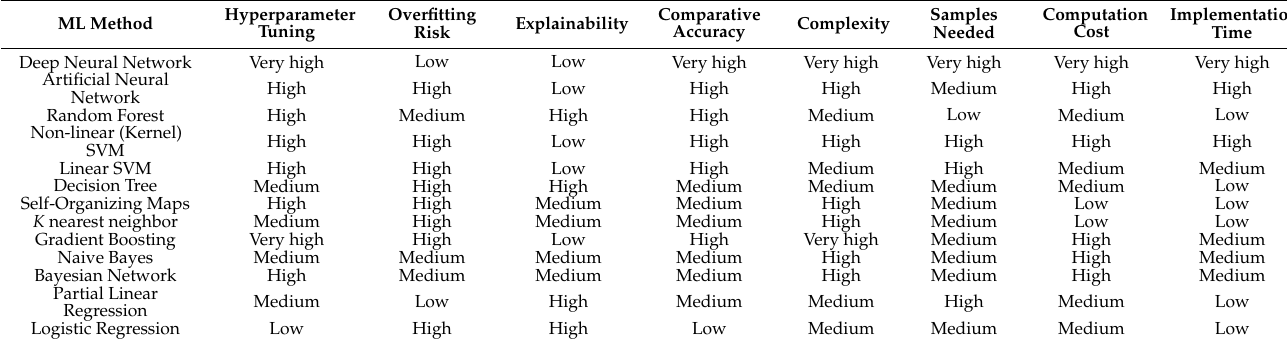
Table 1. The important attributes of different ML methods in plant breeding based on ranking (low, medium, high, and very high).